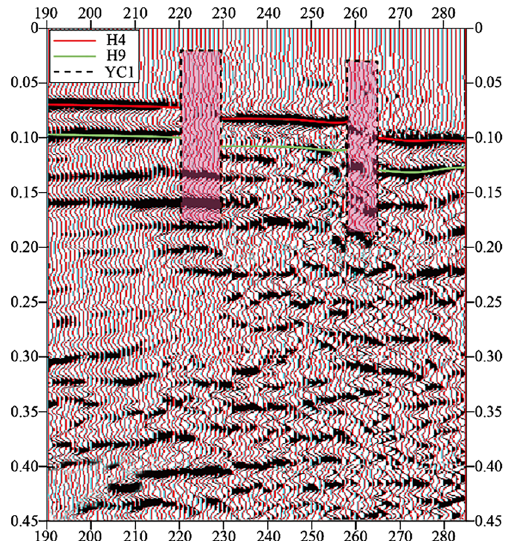
Figure 5. Typical time section of mined-out area in small coal